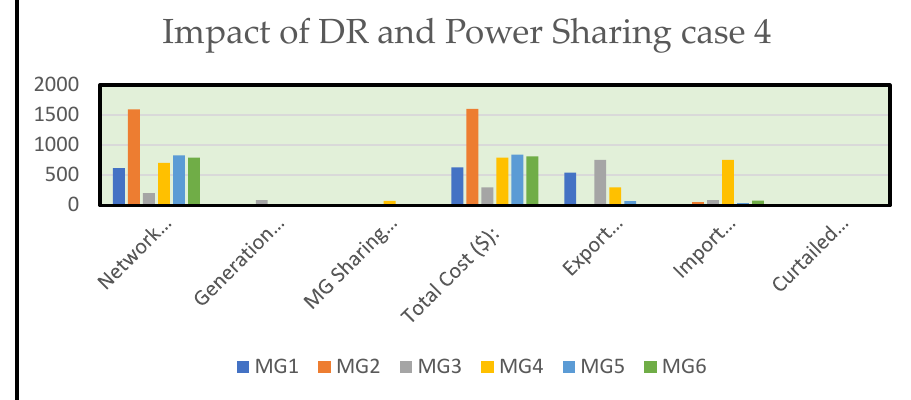
Figure 26. Impact of power-sharing on MG 6.